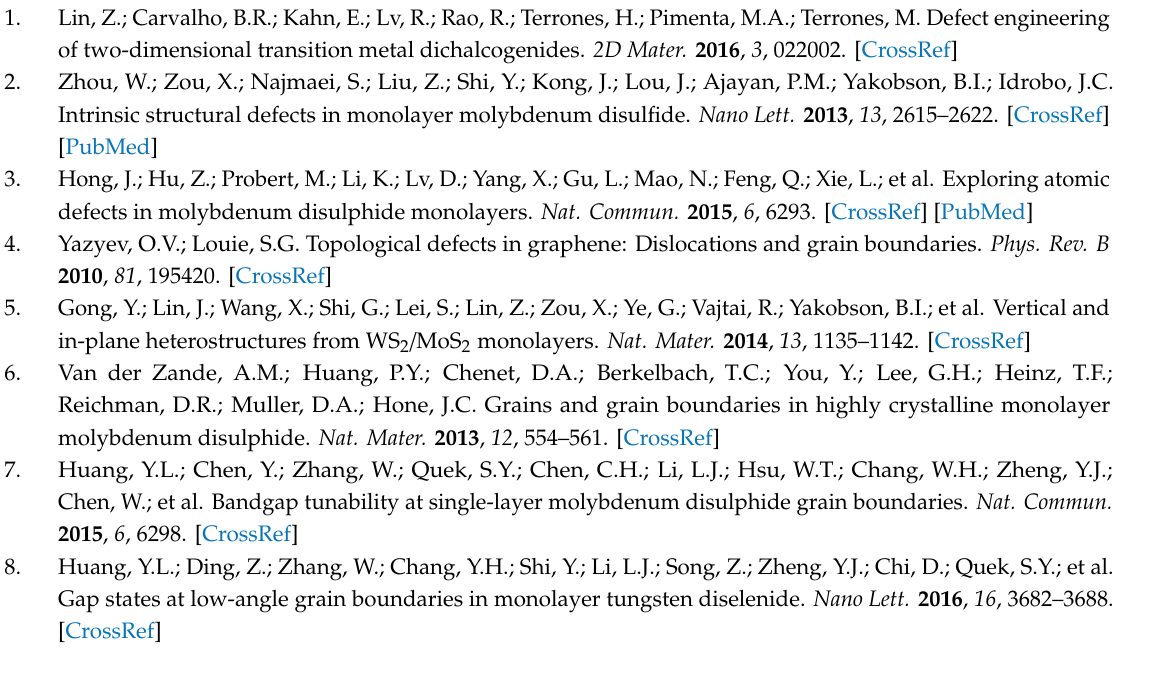
Figure S1: The heated process of the furnace for the tellurium doping. Figure S2: ( a ) The atomic resolution ADF-STEM image of an independent inversion domain and the corresponding MTBs. Here, we choose an independent inversion domain for the convenience of the analysis of the change of Mo lattice atoms and it’s the same as that around the edges. As seen, the number of the comprised Mo lattice atoms along the white lines (marked as 1-7, respectively) passing through the inversion domain is one less than that in the perfect MoS 2. For example, the number of Mo atoms along line 5 is nine, while it’s ten in the perfect MoS 2 lattice. ( b ) The corresponding atomic model of MTBs formed in MoS 2 , in which Mo and S atoms are denoted as salmon and yellow spheres, respectively, and the number of Mo atoms along the black line 1-7 passing through the inversion domain was the same as that in the perfect MoS 2 . Note that the Mo lattice atoms inside the inversion domain are not precisely aligned with some of them sitting upward due to lattice distortion. Figure S3: Schematic illustration showing the area of a triangular MoS 2 domain with a side length of na MoS2 (n = 10) is equal to that of a triangular MoTe 2 domain with a side length of na MoTe2 (n =